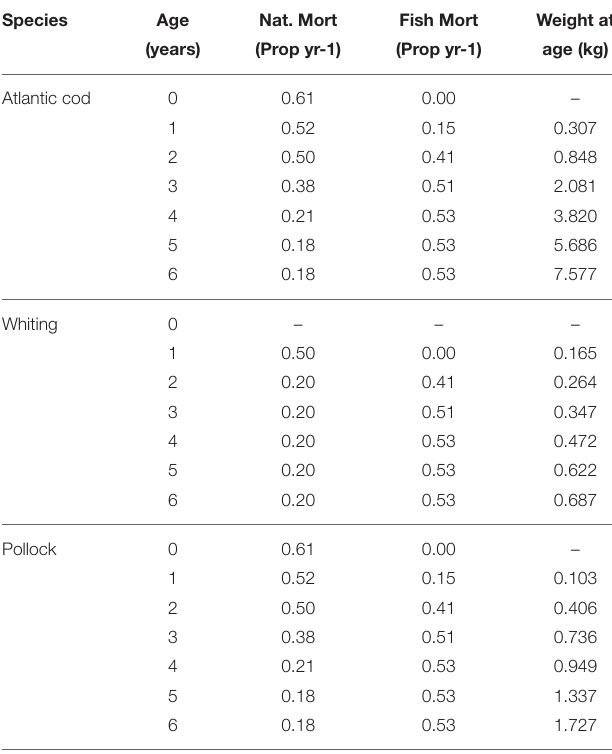
TABLE 3 | Mortality estimates for gaidoids for estimating ecological endpoints for fish production. Species